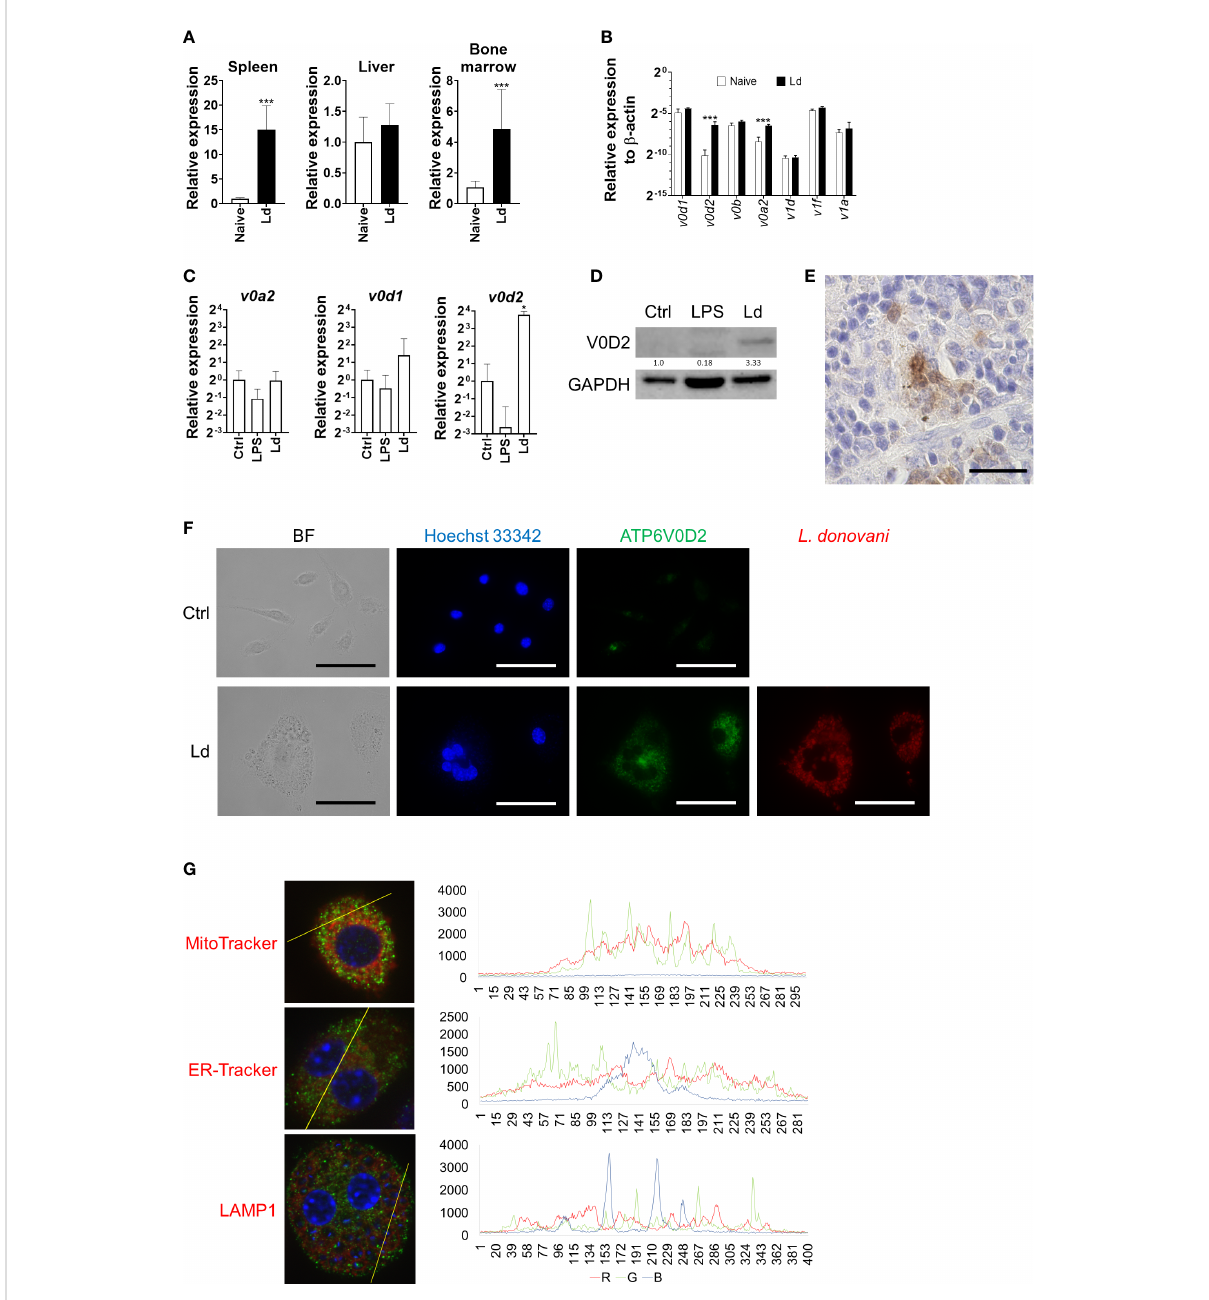
FIGURE 4 Upregulation of ATP6V0D2 expression by Leishmania donovani infection. (A) Expression levels of murine Atp6v0d2 mRNA in the spleen, liver, and bone marrow of naive or L. donovani -infected mice were analyzed by qPCR. Means and SD of the representative data from three independent experiments with similar results are shown. *** P < 0.001 by unpaired t -test. (B) Expression levels of Atp6v0d1 , Atp6v0d2 , Atp6v0b , Atp6v1d , Atp6v1f , and Atp6v1a2 mRNA in the spleen of naive or L. donovani -infected mice were quanti fi ed by qPCR. Means and SD of the representative data from three independent experiments with similar results are shown. *** P < 0.001 by multiple t -tests. (C) BMDMs were either stimulated with LPS or infected with L. donovani for 48 h, and the expression of Atp6v0d1 , Atp6v0d2 , and Atp6v1a2 mRNA was quanti fi ed by qPCR. * P < 0.05 vs. the control group by one-way ANOVA followed by Dunnett ’ s multiple comparisons test. (D) Western blotting for ATP6V0D2 (40 kDa) and GAPDH (35 kDa) in untreated, LPS-stimulated, or L. donovani -infected BMDMs. (E) ATP6V0D2-positive MGC in the spleen of L. donovani -infected mouse, Bars, 50 m m. (F) Untreated BMDMs or L. donovani -infected BMDMs were stained for ATP6V0D2 with Hoechst 33342 counterstaining. BF, bright fi eld. (G) Leishmania donovani -infected BMDMs were fi xed and stained for ATP6V0D2 coupled with staining with MitoTracker, ER-Tracker, or anti-LAMP1. Representative photos of two independent experiments with similar results are shown. Colocalization analyses were performed using the plot pro fi le tool of ImageJ Fiji. Bars, 50 m